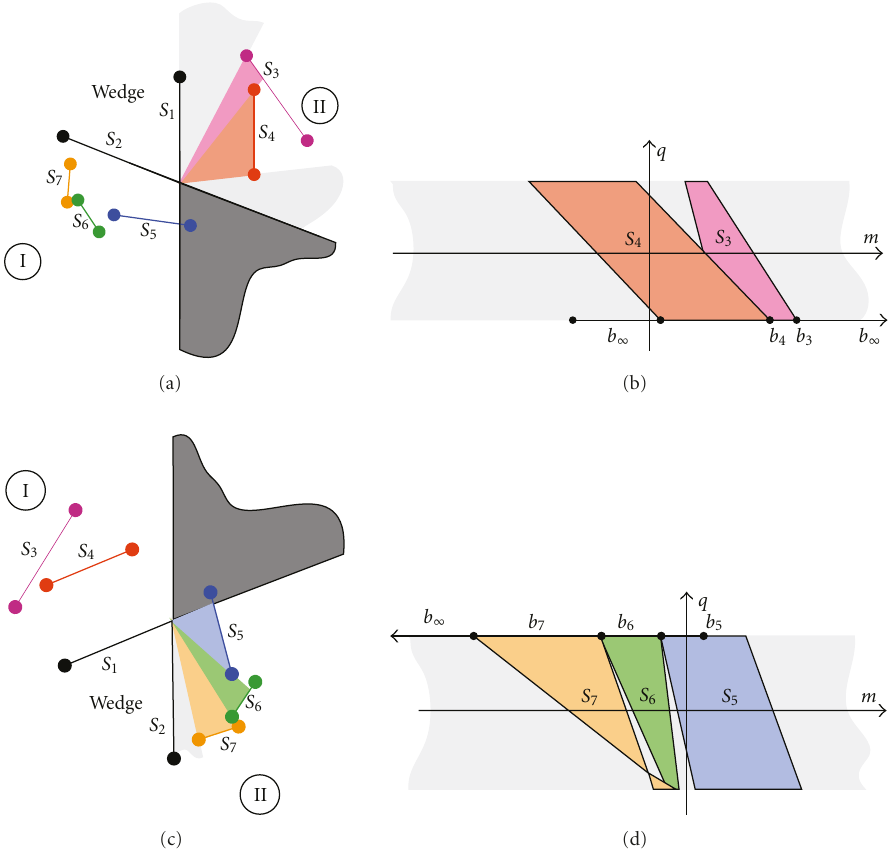
Figure 12: When the source and the receiver fall outside the regions I and II, di ff raction becomes negligible. The di ff ractive beam-trees will therefore cover regions I and II